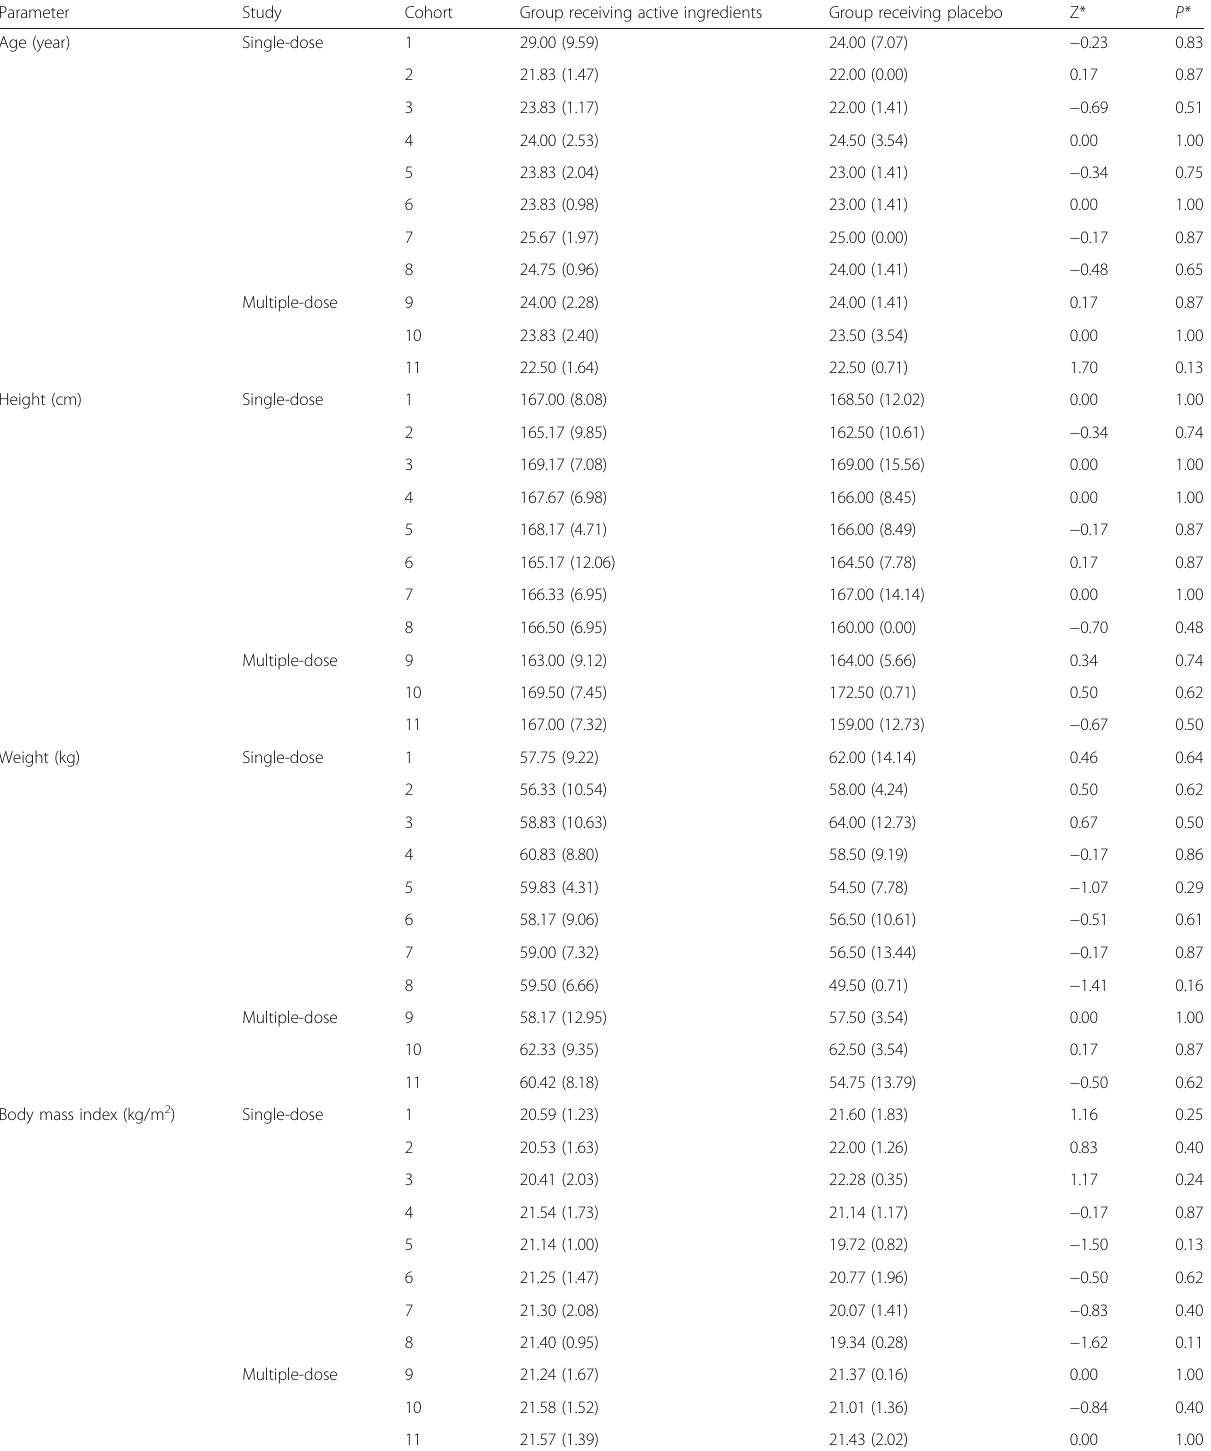
Table 2 Characteristics of subjects in each cohort